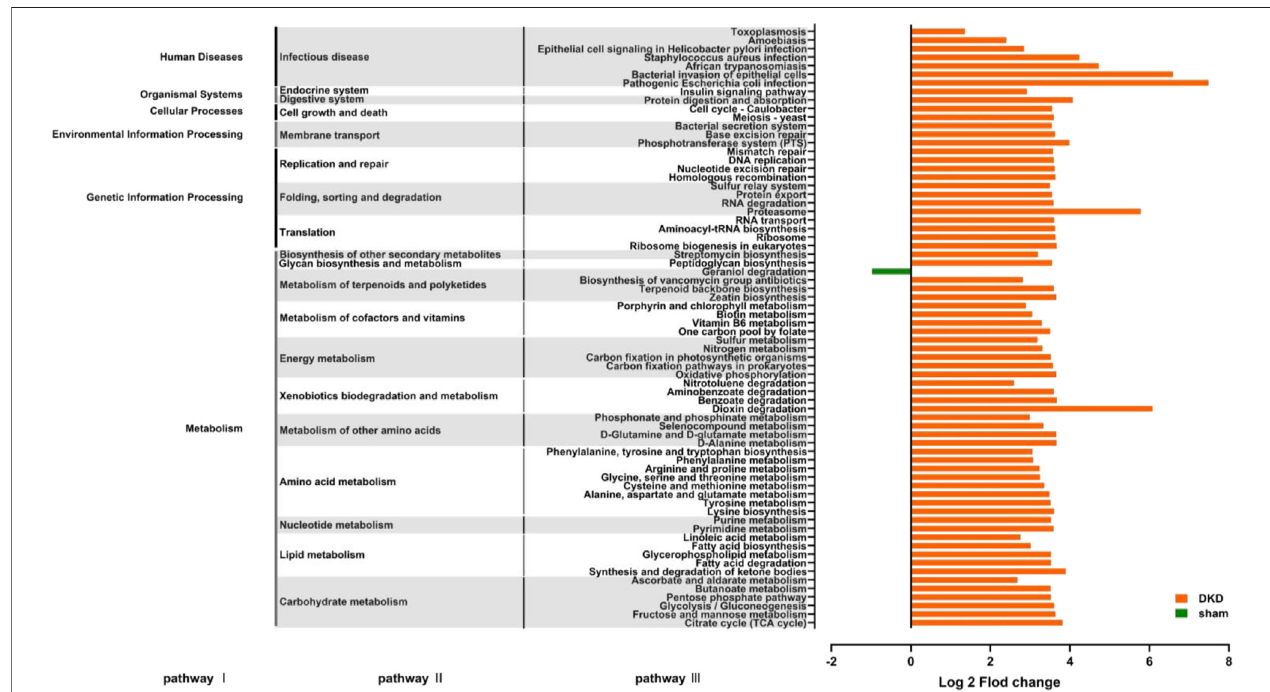
FIGURE 7 | Predicting the effects of changes in the structure and abundance of intestinal fl ora on functional pathways. A total of 70 predictive pathways were screened out using Wilcoxon rank-sum test ( p < 0.05).